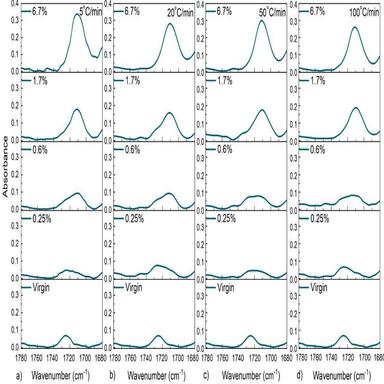
The development of the 1711 cm-1 peak in CF-PEEK samples heated in static air conditions with 5, 20, 50 and 100 ◦C/min up to a resulting mass loss of 0.25%, 0.6%, 1.7% and 6.7%.